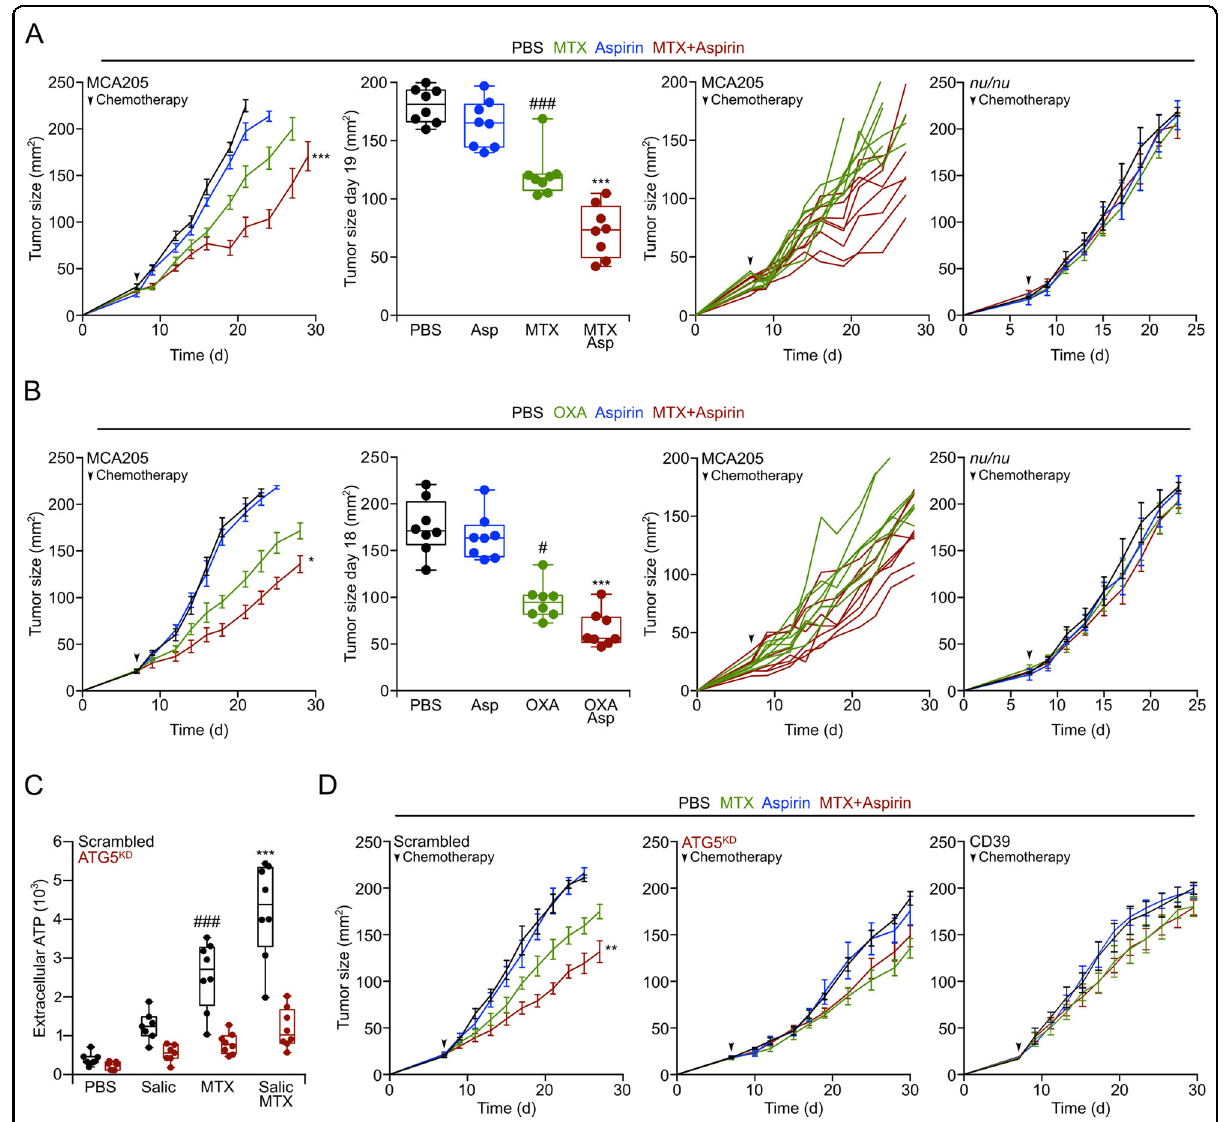
Fig. 6 Aspirin improves chemotherapy in an immune system and autophagy-dependent fashion. a , b WT immunocompetent and athymic ( nu/nu ) mice were subcutaneously injected with MCA205 cells and when tumors became palpable, were divided into four groups and intraperitoneally treated with 5.17 mg/kg mitoxantrone (MTX) ( a ) or 10 mg/kg oxaliplatin (OXA) ( b ), alone or in combination with daily 100 mg/kg i.p. aspirin administration, or an equivalent volume of PBS. From left to right: (1) means ± s.e.m. tumor growth curves of WT mice treated with aspirin alone or in combination with MTX or OXA ( n = 8 mice per group); (2) tumor size distribution at day 19 (MTX) or day 18 (OXA) of data shown in (1); (3) individual growth curves from mice treated with MTX or OXA alone or combined with aspirin of data shown in (1); (4) averaged ± s.e.m. tumor growth curves from immunode fi cient nu/nu mice subjected to aspirin administration alone or in combination with MTX ( n = 5 mice/group) or OXA (Ctrl, OXA and aspirin with n = 5 mice/group, OXA + aspirin n = 6 mice/condition). PBS and aspirin groups are shared in ( a ) and ( b ) for the nu/nu mice experiment. c Extracellular ATP levels (n = 7/8 replicates) were measured in the supernatants of autophagy competent or Atg5 KD MCA205 cells treated with 2 mM MTX and/or 5 mM sodium salicylate (Salic). d WT mice were inoculated subcutaneously with autophagy competent cells expressing a scrambled control shRNA (left panel) or Atg5 KD MCA205 cells (middle panels) or with CD39 overexpressing MCA205 cells (right panel). When tumors became palpable, mice were treated as in ( a ) ( n = 8 mice/condition). Data are shown as means ± s.e.m. for tumor growth curves, as individual curves of each mice in the group, or as box and whisker plots, which show median, fi rst and third quartiles, and maximum and minimum values. Circles in the graphs ( a , b ) indicate each mouse used in the experiment, in ( c ) indicate each replicate. Statistical analysis was performed by linear mixed effect modeling (over the whole-time course) and linear modeling for the single time point (* p < 0.05, ** p < 0.01, ** *p < 0.001 for MTX or OXA versus MTX + aspirin or OXA + aspirin; # p < 0.05, ### p < 0.001 for PBS versus MTX or OXA alone). In ( c ) statistical analysis was done by two-way ANOVA Tukey ’ s multiple comparisons test (*** p < 0.001 MTX versus MTX + salicylate, ### p < 0.001 PBS versus MTX). Asp aspirin, d day, MTX mitoxantrone, OXA oxaliplatin, Salic